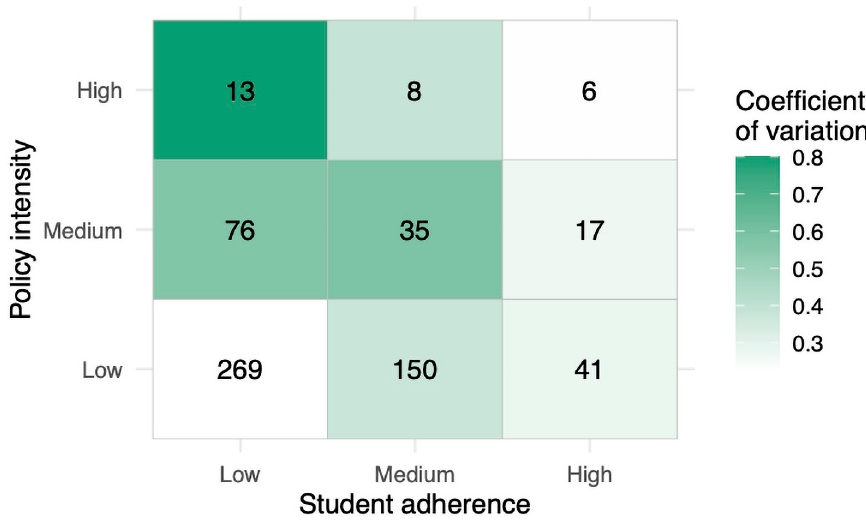
Fig 7. The total number of cases (numeric) and the coefficient of variation (standard deviation/mean; colorbars) for different policy and adherence intensity levels.